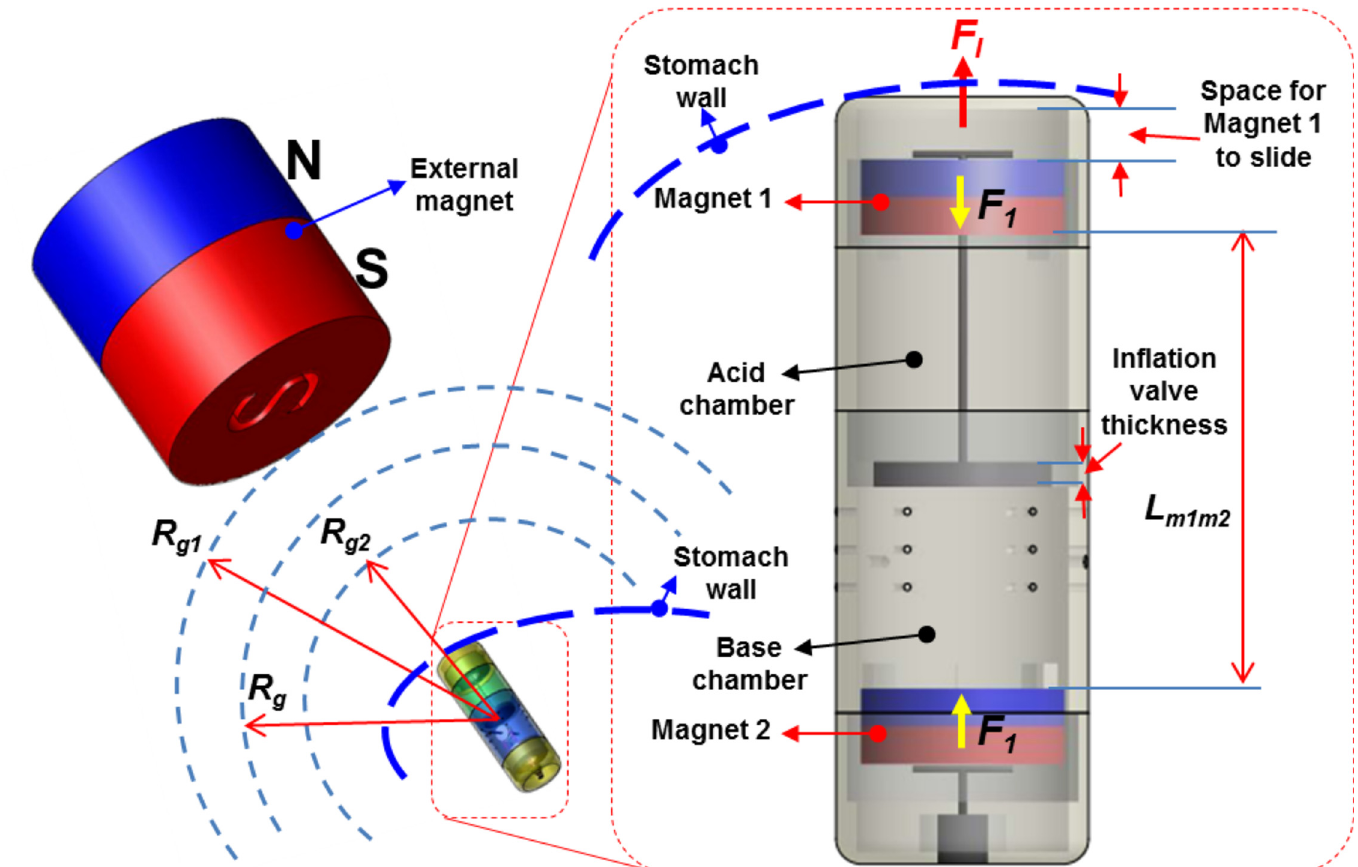
Fig 6. Operation principle for the inflation